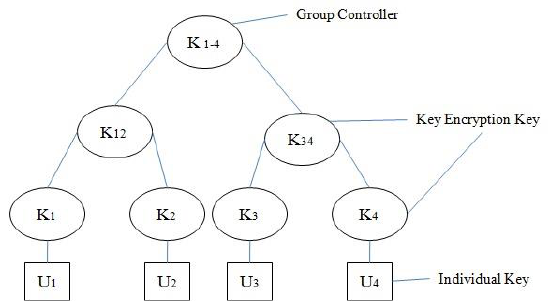
Figure 1: Structure of Logical Key